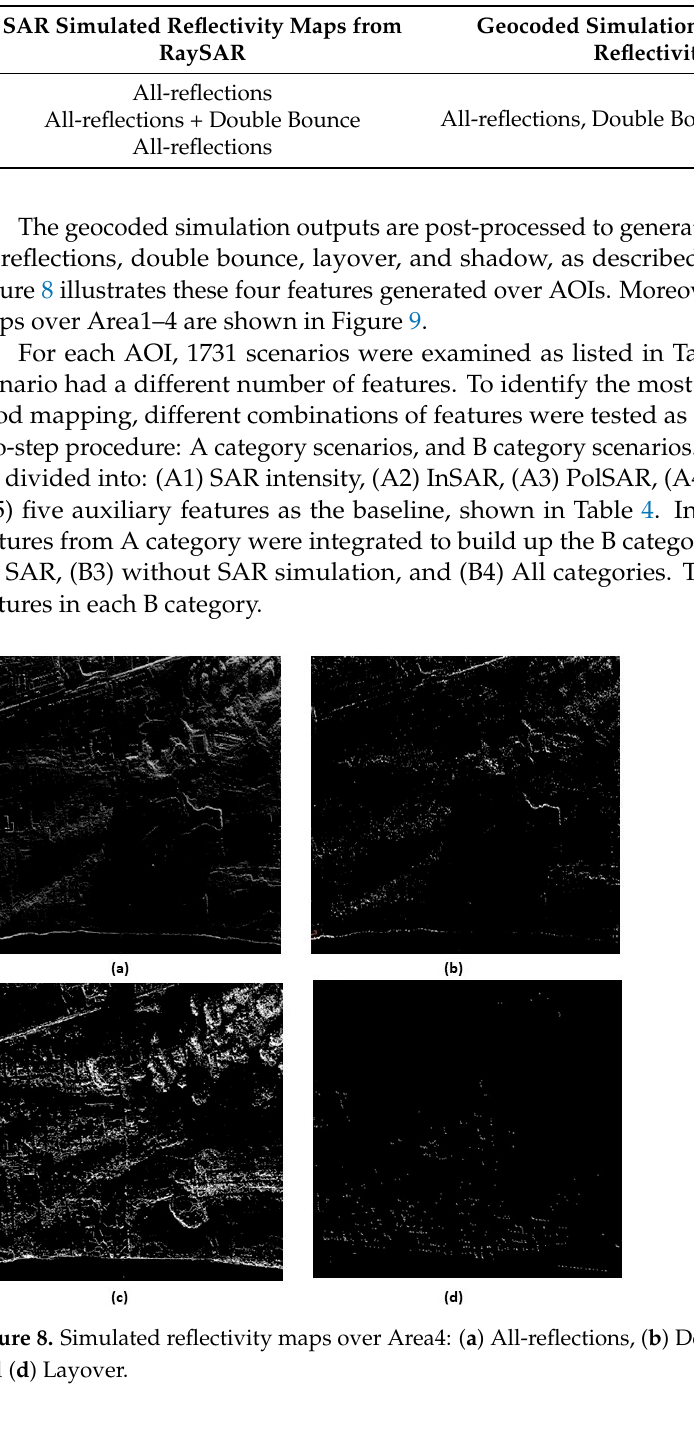
Figure 9. Generated flood maps over ( a ) Area1, ( b ) Area2, ( c ) Area3, and ( d ) Area4. Blue areas indicate water bodies and the river, while black and white areas show non-flooded and flooded areas, respectively. For each AOI, 1731 scenarios were examined as listed in Tables 4 and 5 and each scenario had a different number of features. To identify the most important features for flood mapping, different combinations of features were tested as different scenarios in a two-step procedure: A category scenarios, and B category scenarios. In A category, features are divided into: (A1) SAR intensity, (A2) InSAR, (A3) PolSAR, (A4) SAR